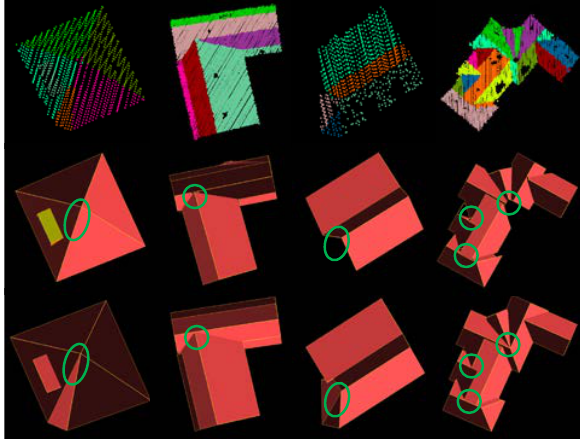
Figure 7. Model improvements by new library. First row: laser points coloured; Second row: models reconstructed by the prior library; Third row: models reconstructed by the new library.